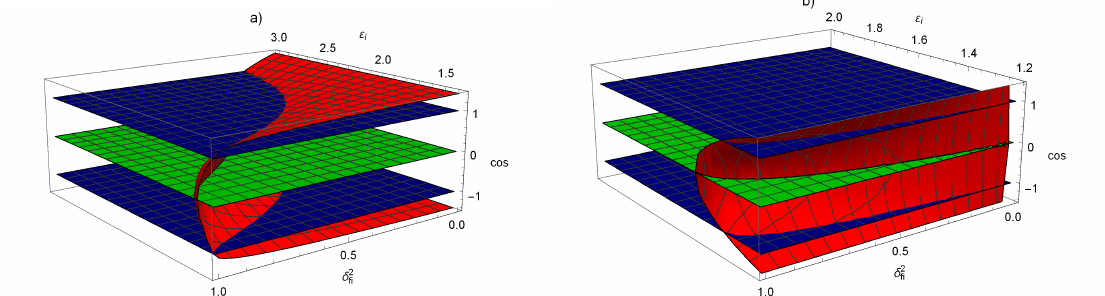
(cid:16) (cid:17) Figure 5. Surface (red) in ε i , δ fi ,cos ( ϕ fi − ϕ + i ) -parametric space which separates the region in this space where the process is kinematically allowed from the region where the process in kinematically forbidden for high ( a ) and low ( b ) values of the final electron energy. Blue planes correspond to cos ( ϕ fi − ϕ + i ) = ± 1 and the green one to cos ( ϕ fi − ϕ + i ) =